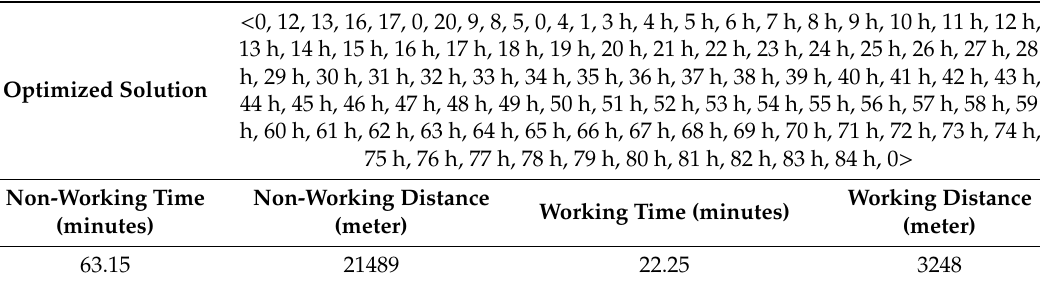
Table 8. The optimized solution with the simulation results.